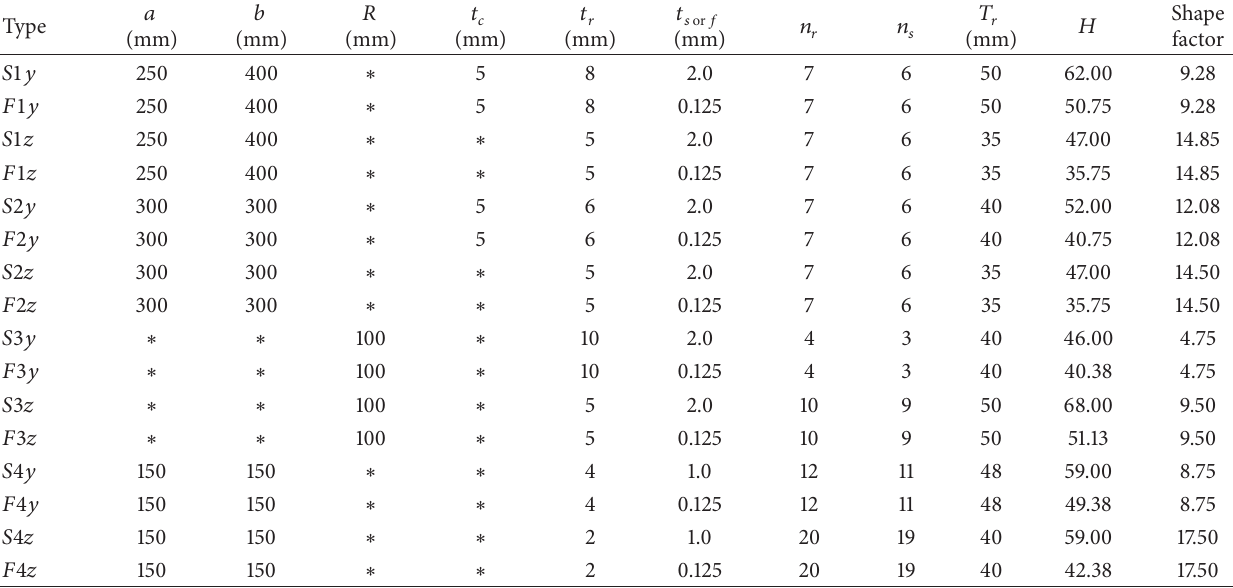
Table 1: Properties of steel-reinforced and fiber-reinforced